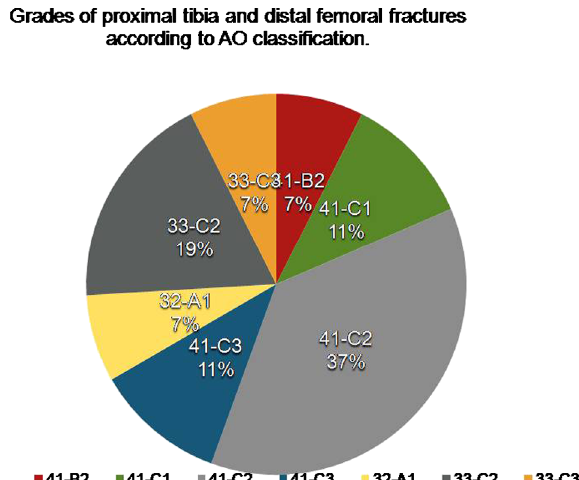
Figure 1. Types of tibial plateau and distal femoral fractures included in this study classi fi ed according to Muller ’ s AO classi fi cation